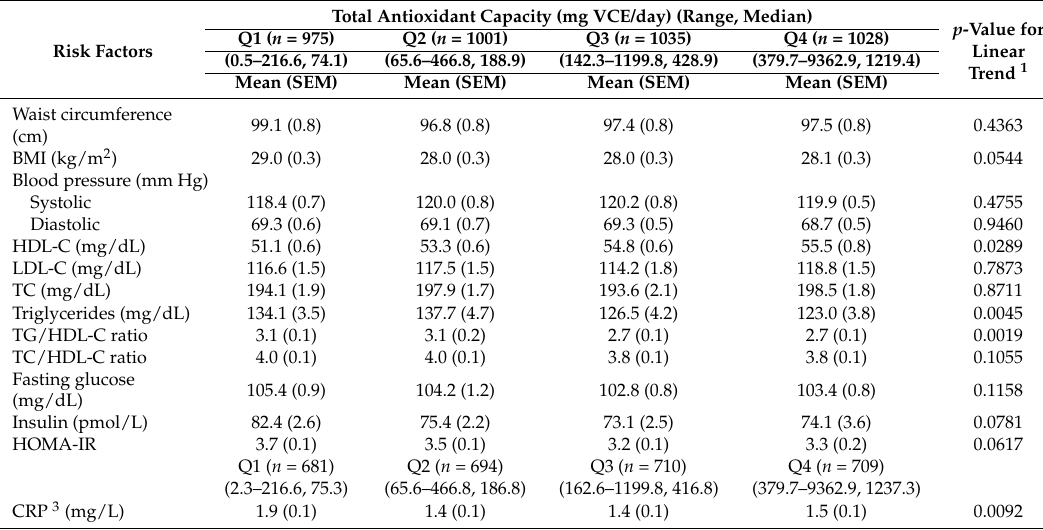
Table 5. Cardiovascular disease risk factors according to energy-adjusted quartiles of total antioxidant capacity among U.S. adults in the NHANES 2007–2012 ( n = 4039).